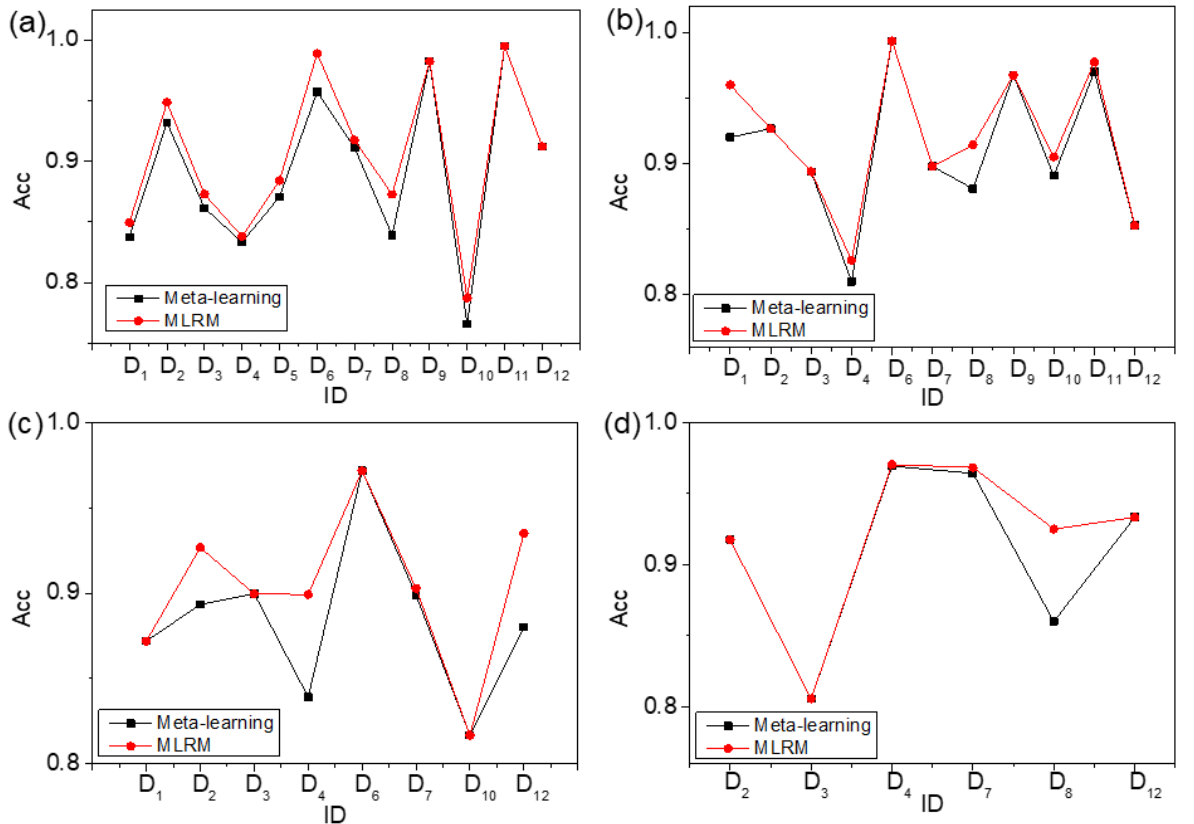
Figure 9. Accuracy comparison between MLRM and meta-learning. ( a ) all, ( b ) quinaries, ( c ) senaries, and ( d ) septenaries.